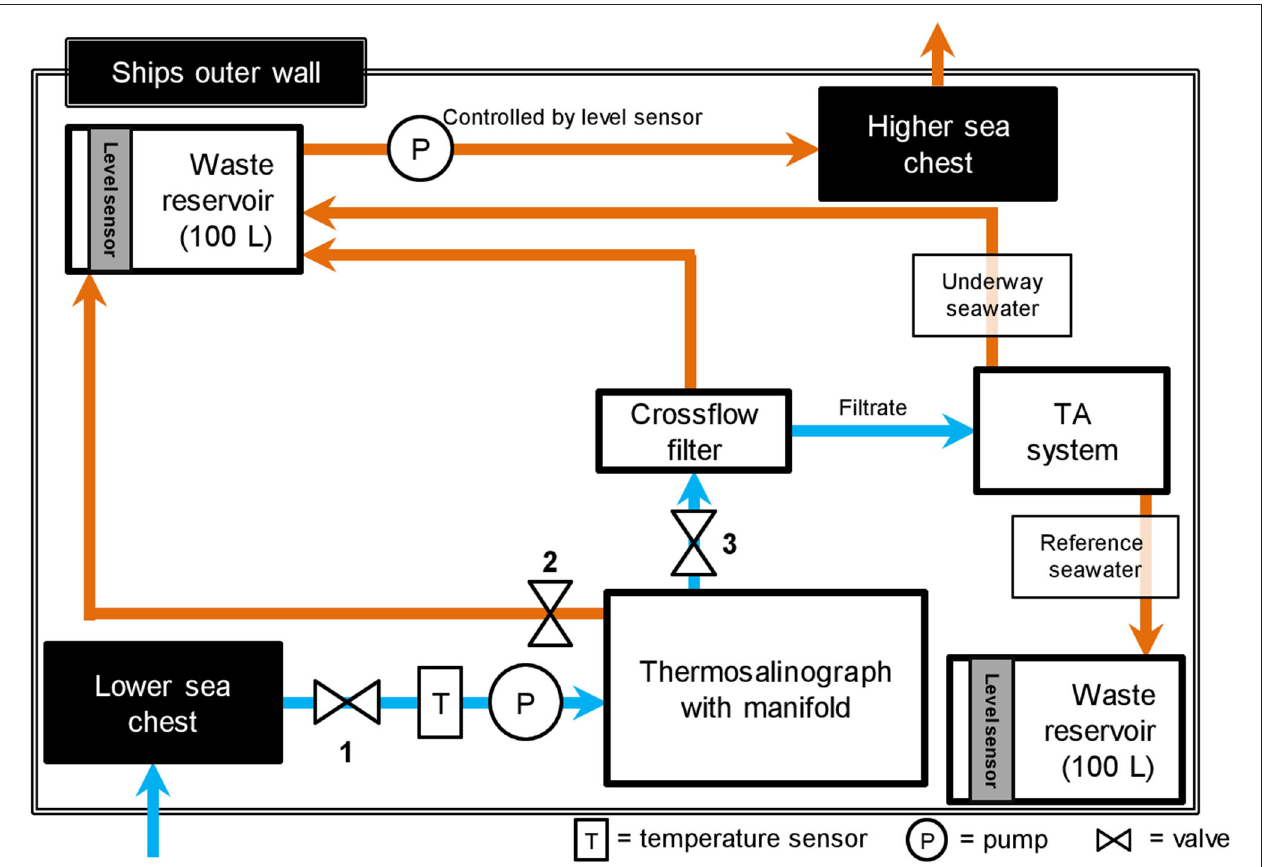
FIGURE 2 | Schematic illustration (not to scale) of the onboard installation for seawater measurements. Black filled boxes represent ship facilities. White filled boxes represent our installations. Blue arrows, and orange arrows represent the water flow of fresh seawater, and waste seawater,